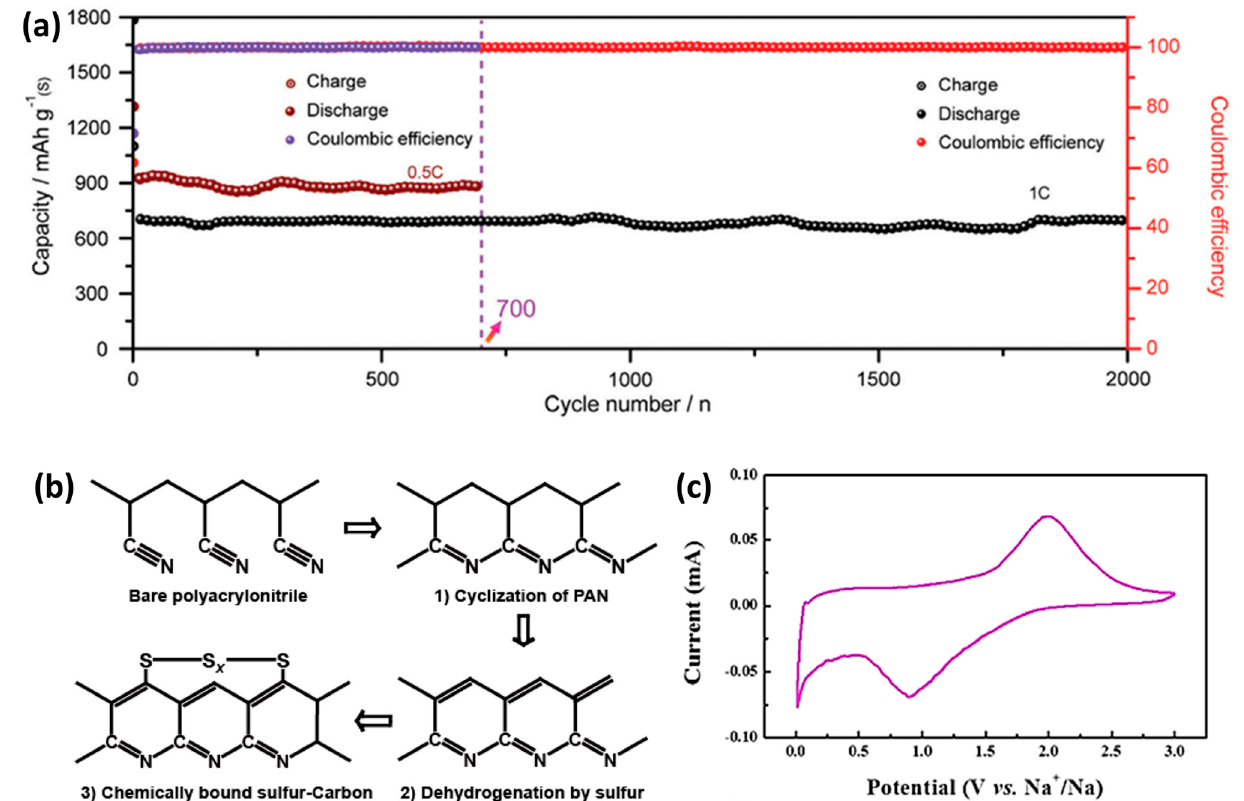
Figure 5. ( a ) Cycle performances of the ACC-40S electrode at 0.5 and 1 C for 700 and 2000 cycles, respectively. ( b ) Structural changes during carbonization and sulfurization of PANs. ( c ) The CV curve of the covalent sulfur-based carbonaceous (CSCM) cathode at the scan rate of 0.1 mV s − 1 with a voltage range of 0.01–3.0 V.